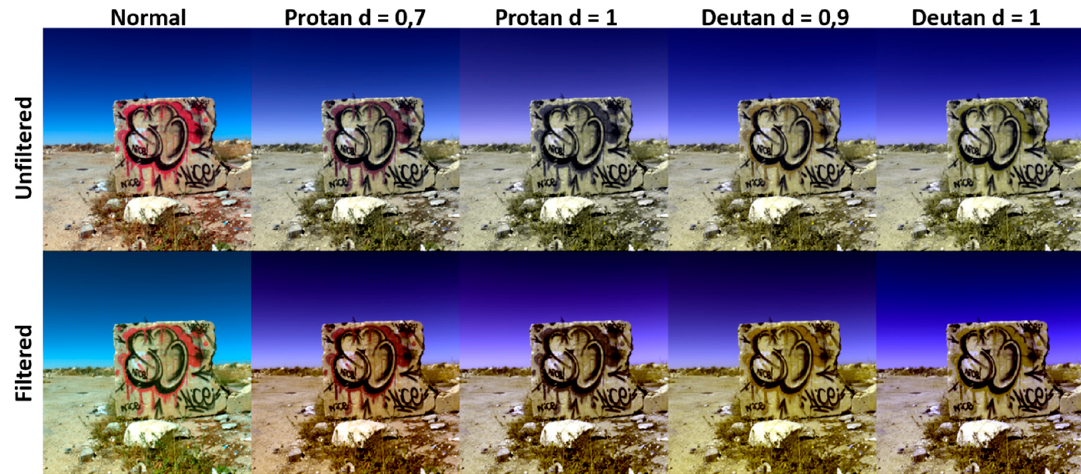
Figure 7. sRGB rendering of one of the scenes in dataset D2, for all simulated observers. First row: unfiltered. Second row: filtered.